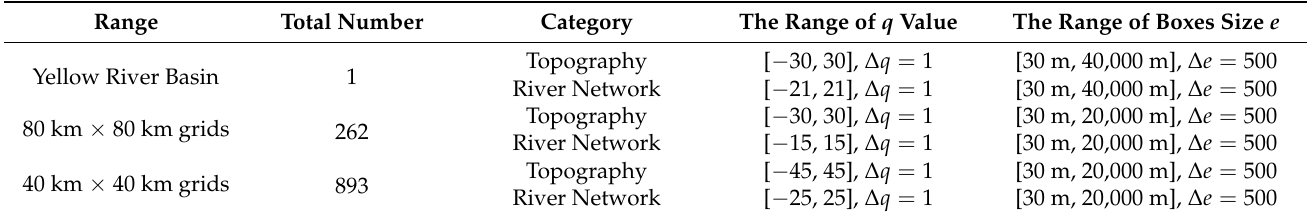
Table 1. Scale range for calculating multifractal features in the Yellow River Basin.